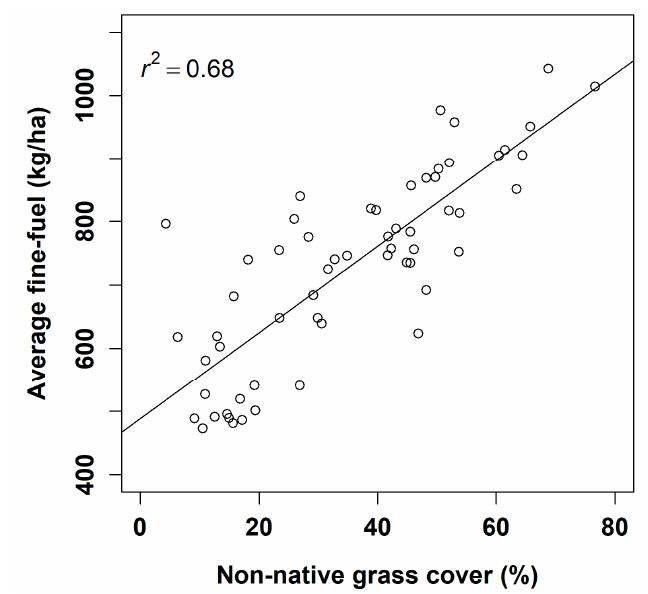
Figure 16. Fine-fuels and fuel-type data compared within principal fire management units ( n = 59) on the Buenos Aires National Wildlife Refuge (BANWR) showed a strong positive relationship between non-native grass cover and average fine-fuel biomass.